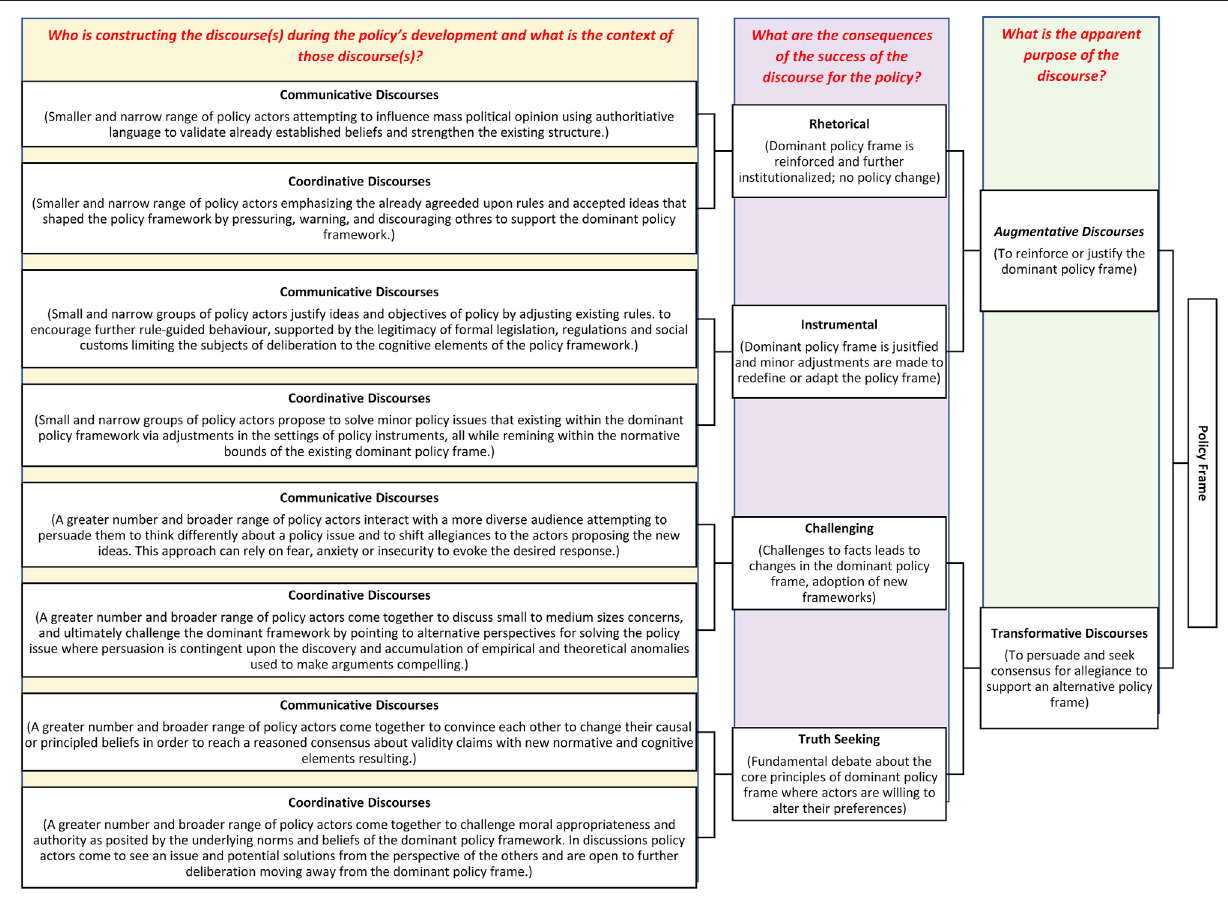
Frontiers in Communication |